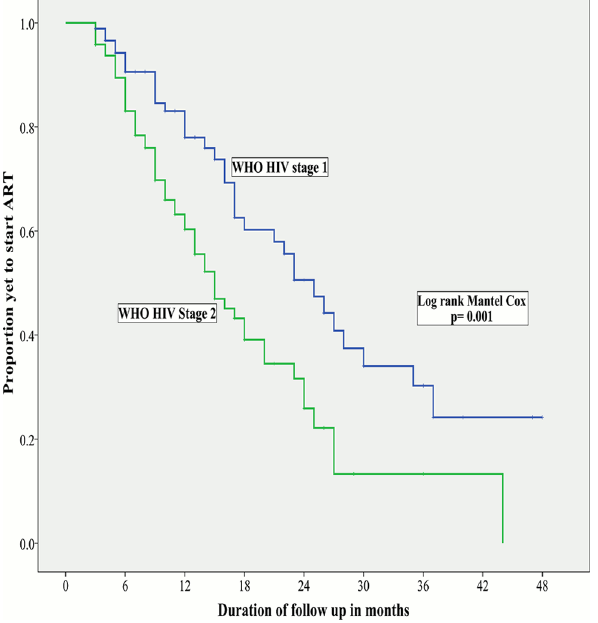
Fig 2. Kaplan-Meier curves of time to initiation of ART in relation to WHO HIV stage. The median time to ART initiation was significantly shorter in participants with stage 2 disease (15months) than participants with stage 1 disease (23months).